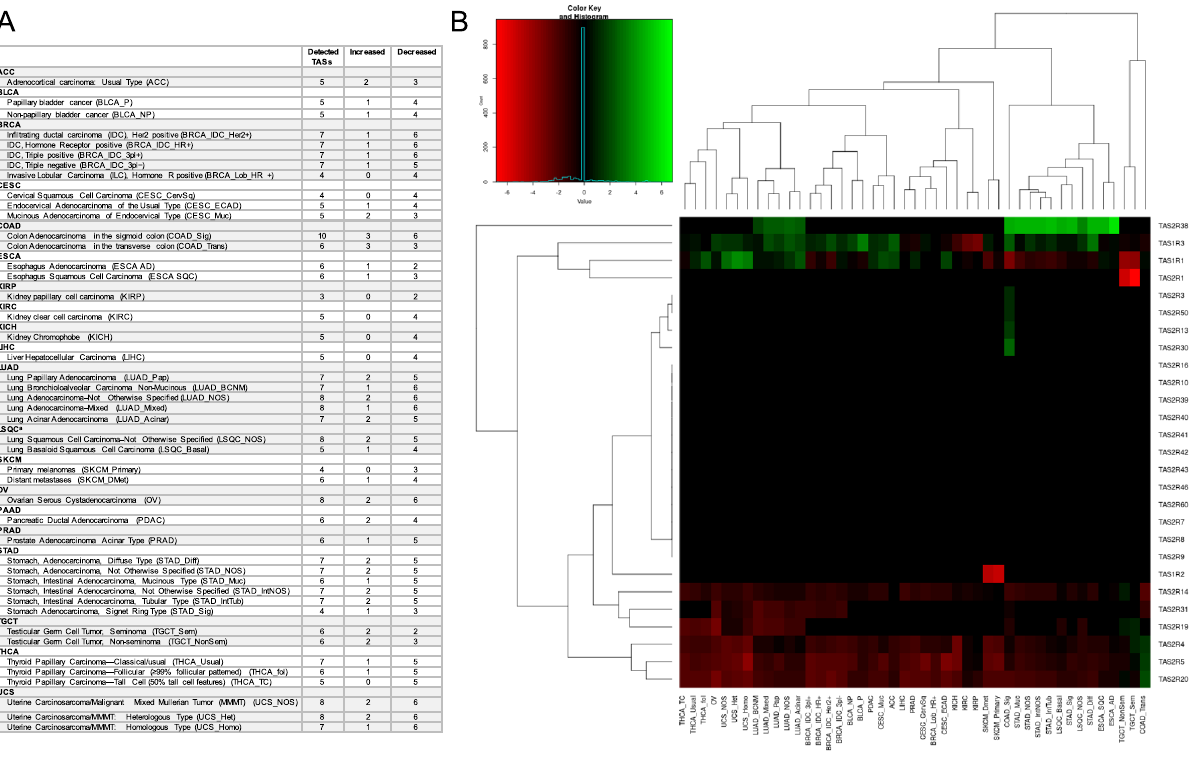
Figure 1. Multiple TAS1R and TAS2R genes are differentially expressed in solid tumors. To determine the differential expression of genes, RNA sequencing data for solid tumor tissues from The Cancer Genome Atlas (TCGA) were compared to corresponding normal tissues from the Genotype Tissue Expression Project (GTEx) database. ( A ) Table showing the solid tumors surveyed for TAS1R/2R differential expression analysis with TCGA cancer type, subtype/histology, and associated abbreviations. The number of TAS1R/2Rs with statistically significant changes in expression are listed for each tumor subtype compared to normal tissue with log2 fold change cutoff > log2(1.5) used for increased expression and < log2(1/1.5) for decreased expression (FDR < 0.05, median TPM > 0.001). ( B ) Heatmap demonstrating log2 fold-change of TAS1R/2R expression in 45 solid tumor subtypes compared to corresponding normal tissue with hierarchical clustering of differential expression. Increased expression shown in green and decreased expression in red. DE differential expression; FDR false discovery rate; GTEx Genotype Tissue Expression Project; TPM Transcripts Per Million; TCGA The Cancer Genome Atlas; a LSQC is abbreviated as LUSC in some